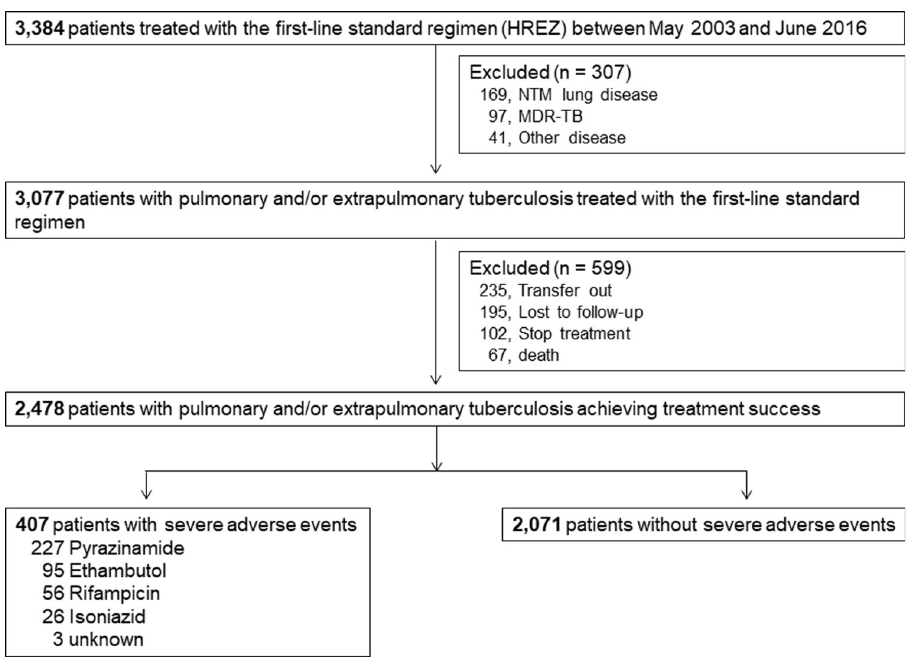
Fig 1. Study flow